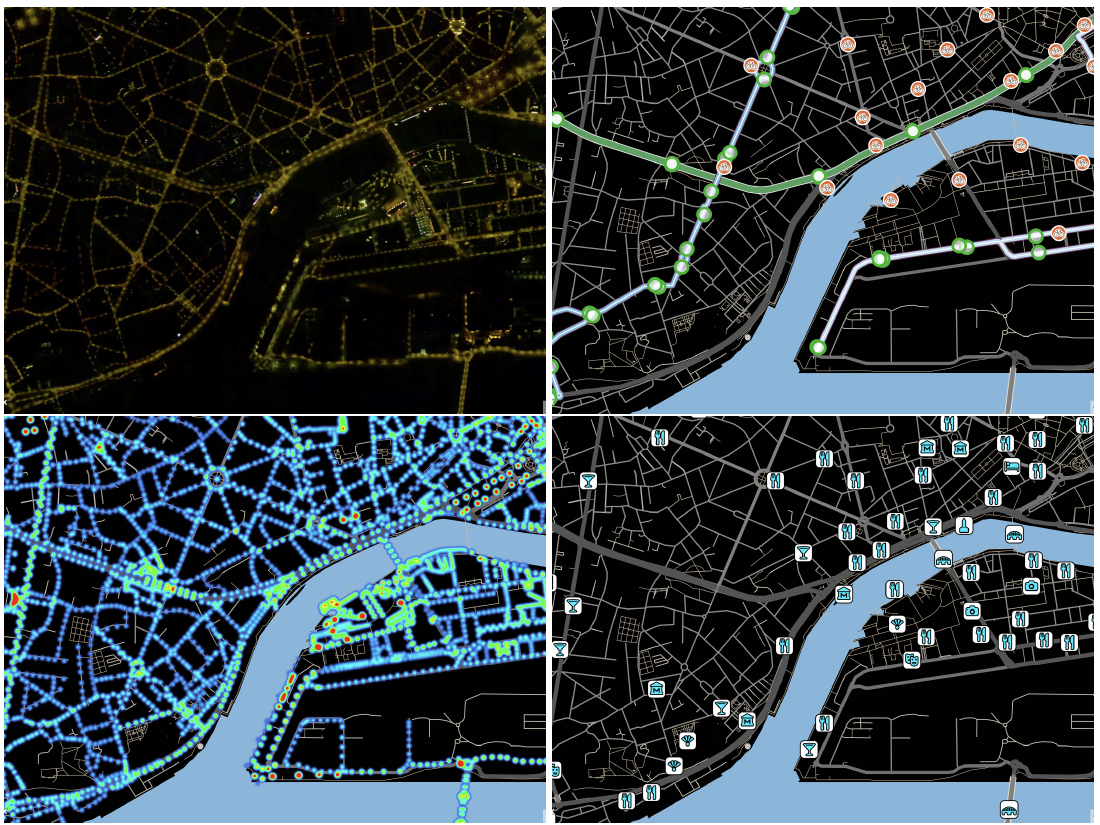
Figure 3. Crops of the four data layers, as used as textures in the MCV systems: light pollution, nighttime transportation, street light energy consumption, and points of interest at